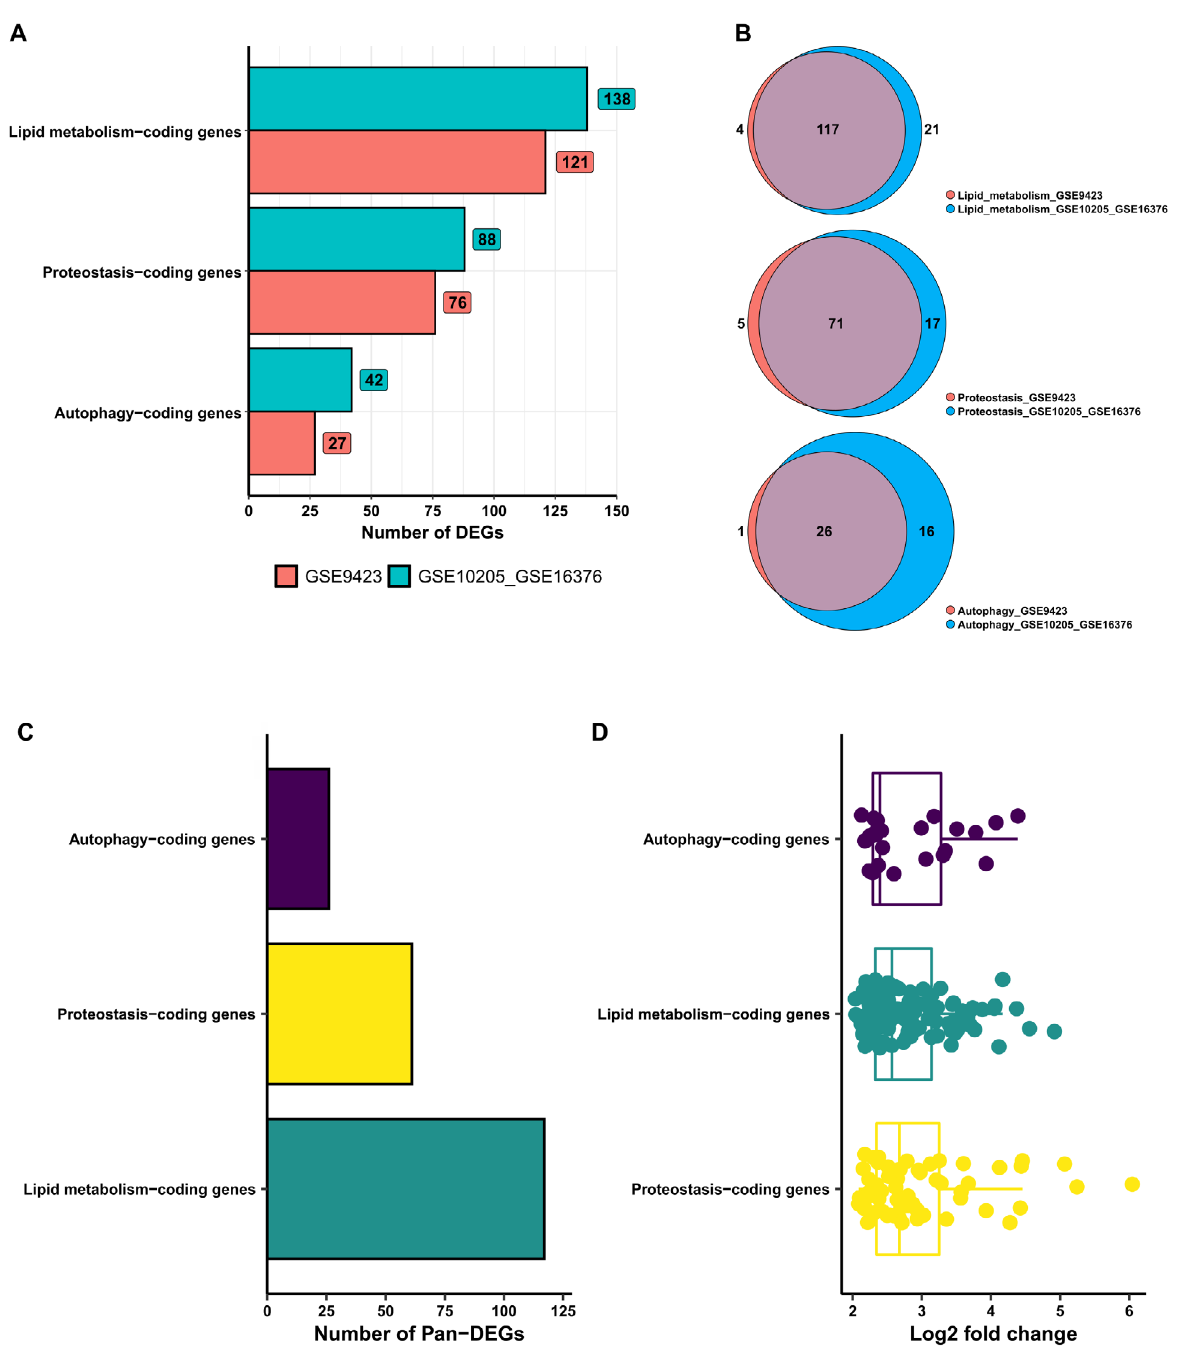
Figure 2 - In (A), Frequency of non-redundant (unique) upregulated differentially expressed genes associated with autophagy, lipid metabolism, and proteostasis (ALP DEGs) in the transcriptome single-analysis (GSE9423) and meta-analysis (GSE10205 versus GSE16376). The numbers inside the squares show the frequency of upregulated DEGs associated with a specific ALP process. The frequencies of ALP DEGs common to both transcriptome analyses (designated ALP Pan-DEGs) are indicated in the (B) Venn diagram and (C) bar chart. In (D) Expression values of ALP Pan-DEGs in log